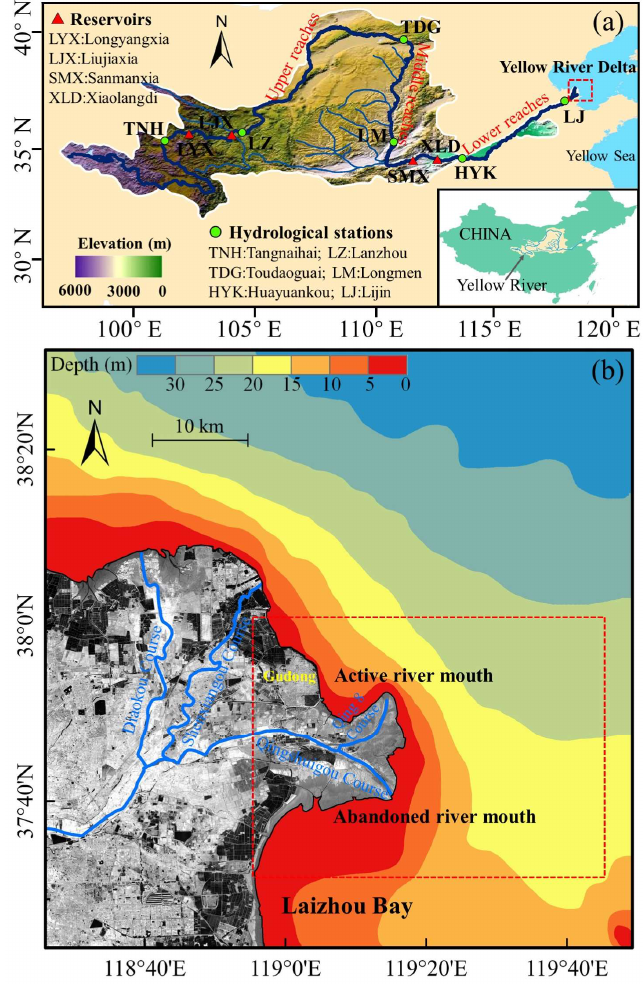
Figure 1. ( a ) Sketch map of the Yellow River basin showing geographic locations of major hydrological stations, reservoirs, and tributaries. ( b ) Topographic map of the Yellow River subaqueous delta. The red polygon denotes the study area.